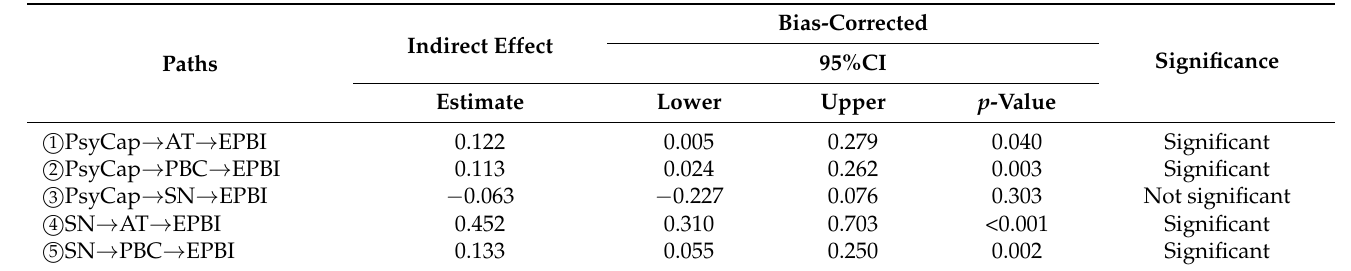
Table 6. Test results of mediating effect of the